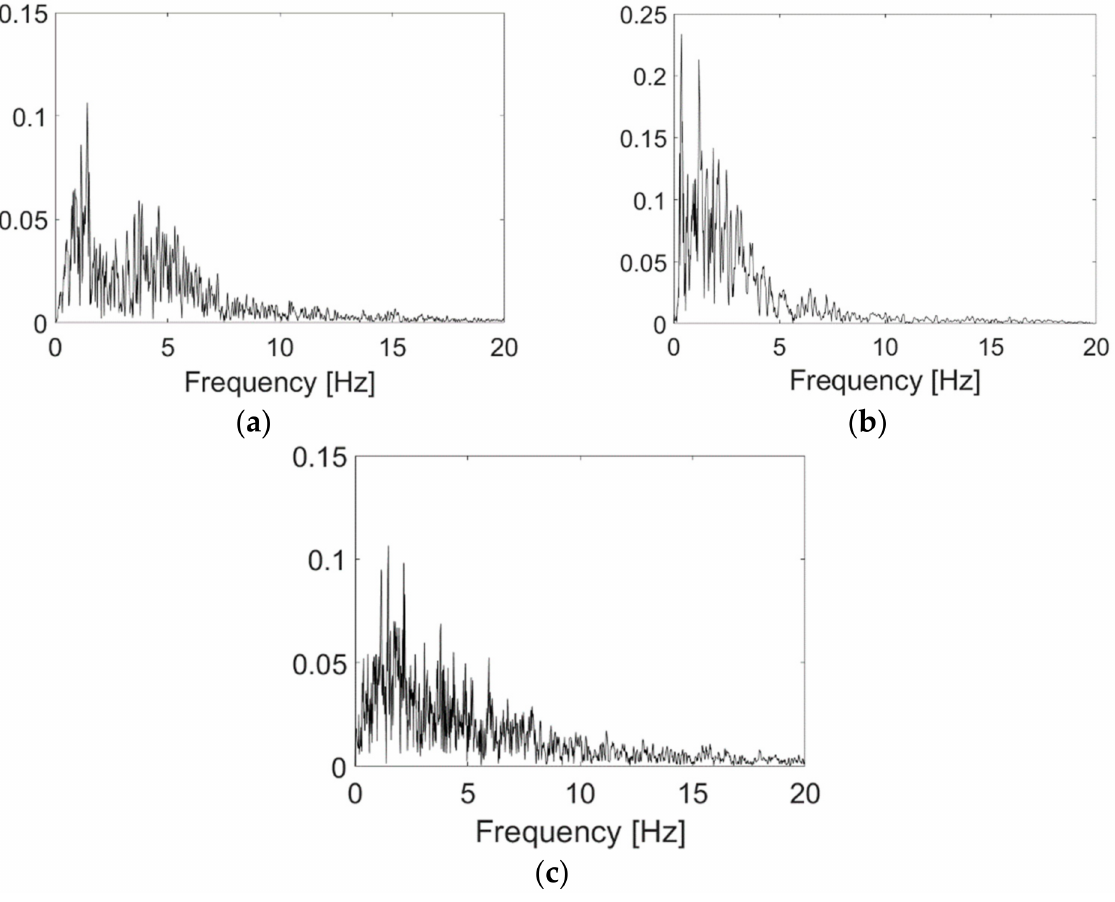
Figure 16. Frequency spectra: ( a ) L’Aquila earthquake; ( b ) El Centro earthquake; ( c ) Newhall earthquake. Table 5 summarizes the main mechanical characteristics of the selected floor